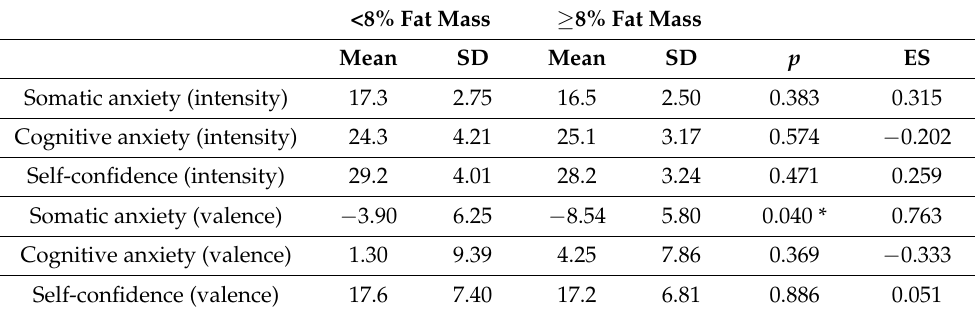
Table 2. Difference of means in anxiety dimensions as a function of fat mass percentage.